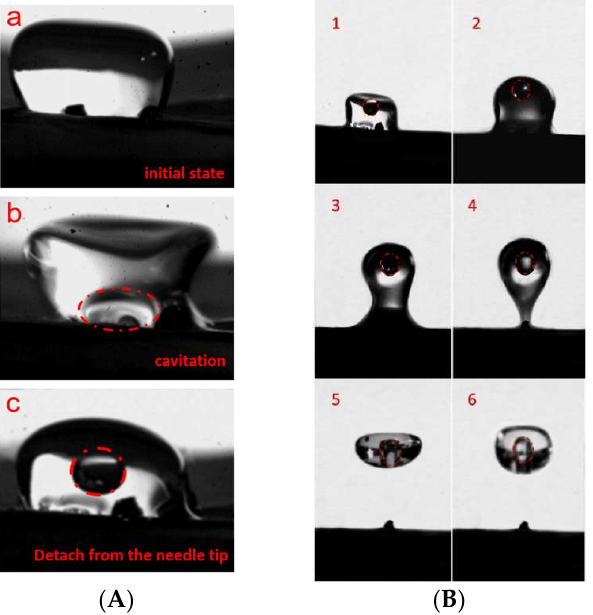
Figure 12. ( A ) Cavitation process of water droplets. ( B ) Droplet acoustic levitation process .